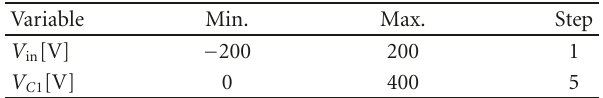
Table 3: Look-up table for simulationof the second and third block (size 1MB).